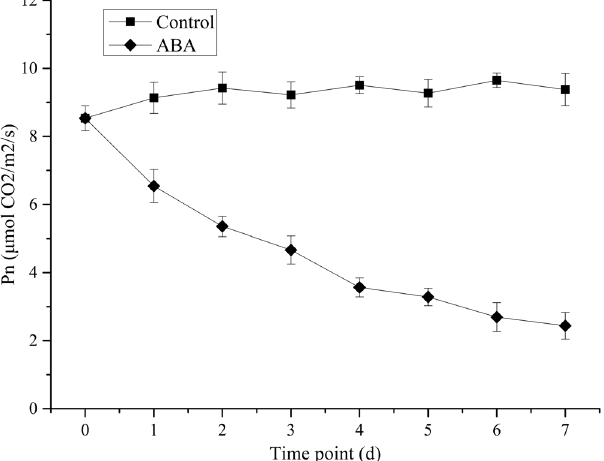
Figure 4. Effects of ABA treatment on net photosynthesis rate of duckweed. All data are presented as the mean of triplicate measurements ± standard deviation.